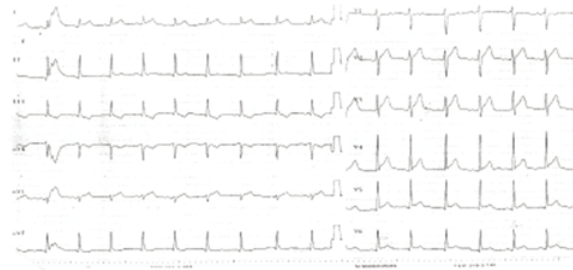
Figure 1: Anteroseptal ST elevations on leads DI, aVL, V2 to V6, and reciprocal ST depressions on leads DIII, aVF indicating acute anterolateral myocardial infarction.